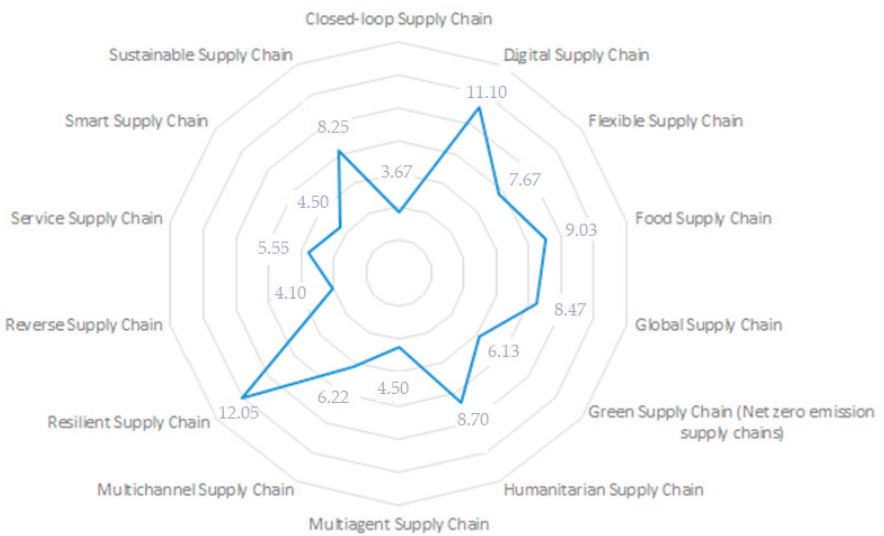
Figure 12. Mean ranking values of global theoretical trends and supply chain development directions in the context of dynamic global changes related to the COVID-19 pandemic according to the experts’ assessments 1–30; own elaboration based on the conducted research.